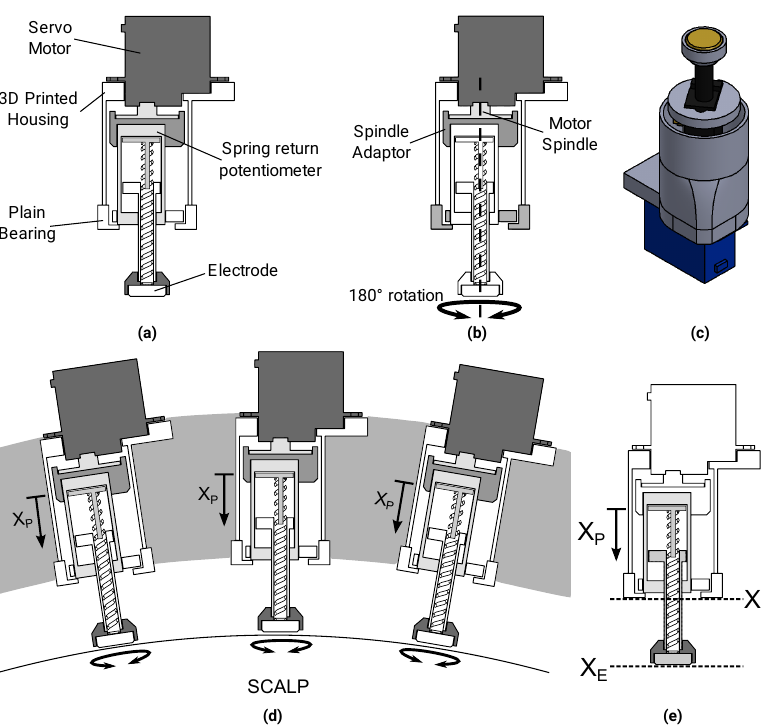
Figure 8. Self-Abrading Electrode Unit Design ( a ) overview of components ( b ) concentric rotary actuation via servo motor with plain bearing, ( c ) complete unit ( d ) units placed in rigid helmet at known positions ( e ) feedback of electrode position X E through measurement of displacement X P .